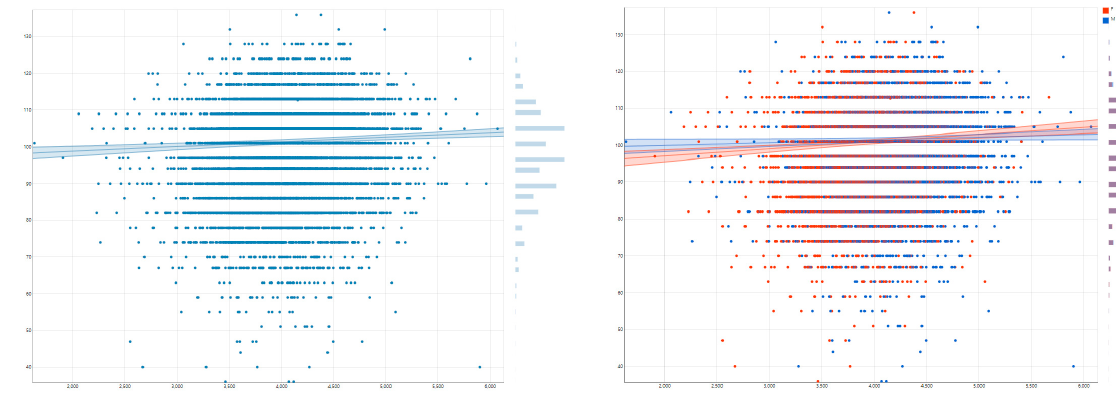
Figure 3. Association between left hippocampal volume and list sorting working memory by sex. ( a ) the overall association;